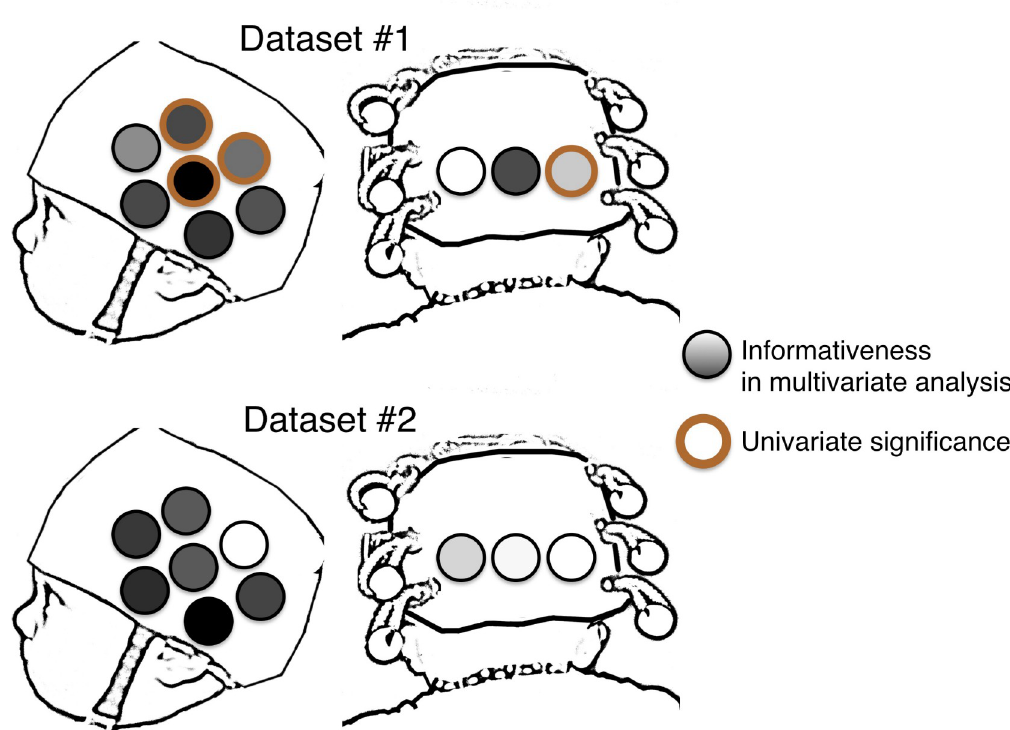
Fig 6. Comparison of the relative informativeness acrosschannels from multivariate analysis (from dark to light, least to most informative respectively) and channels which exhibit a significant difference between the sametwo conditions in a univariate analysis. Across both datasets, only a single channel that exhibitsa significant univariateresponseis one of the most informative channelsin the multivariate analyses.In Dataset #2, not a single channelwas significantfor our univariateanalysisbut we achievesignificantinfant-leveldecodingin the multivariate analysis.